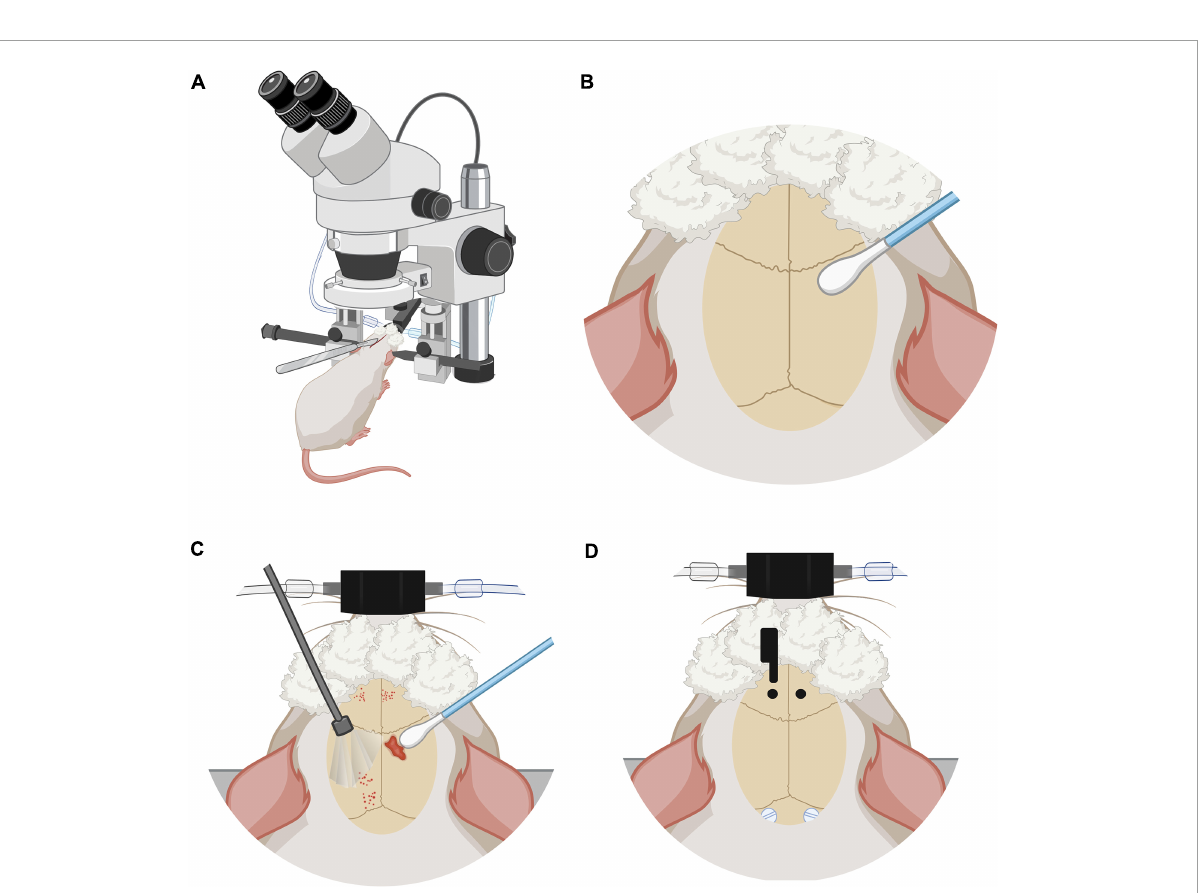
FIGURE2 Anesthesia and stereotaxic surgery. (A) Rat placed in the stereotactic device. Rat under anesthesia vaporized with 3% isoflurane, on stereotaxic frame base with head fixation and a heated cushion under the body. (B) Preparation of the skull and control of local bleeding. Scalp incision on the midline following the direction of the mid-sagittal suture. (C) Curettage of skull aponeurosis and cleaning with swabs. (D) Coordinate marking of implantation coordinates of nylon screws and carbon electrodes under the microscope, directed by stereotaxic frame tower. Trepans on the skull are the entry site for the cortical implantation of the electrodes. Also visible are the nylon screws that are placed to keep the fibers fixed to the skull and maintain their